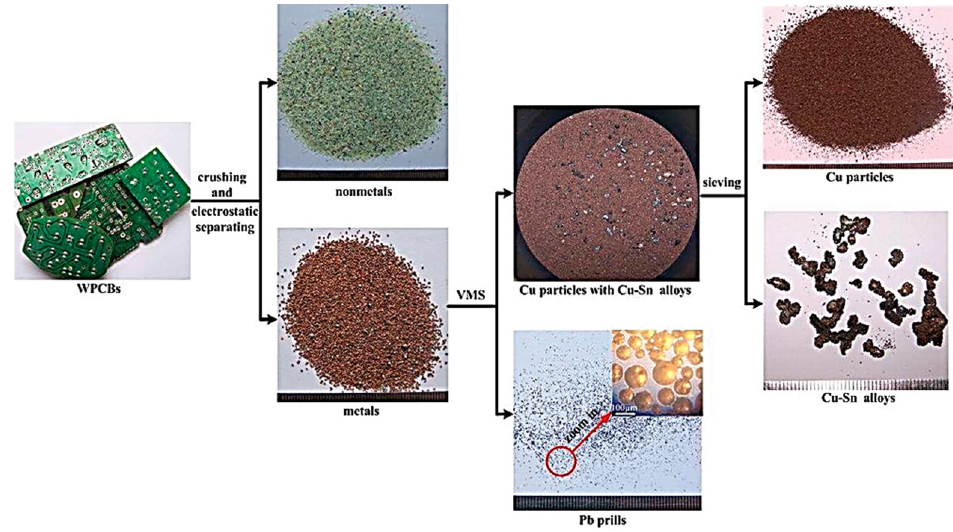
Figure 17. A flowchart representing Pb recycling from waste printed circuit boards (WPCBs) [49].